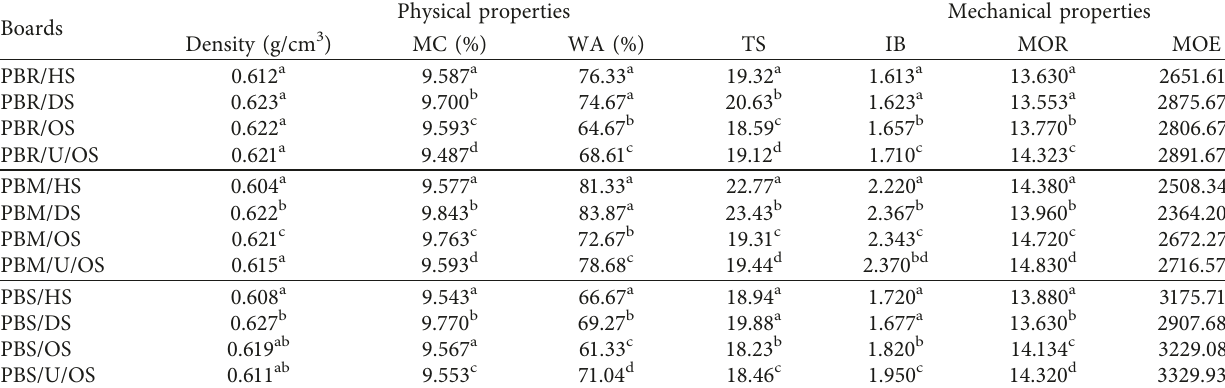
Table 1: Average values of physical and mechanical properties of particleboards formulated. Boards